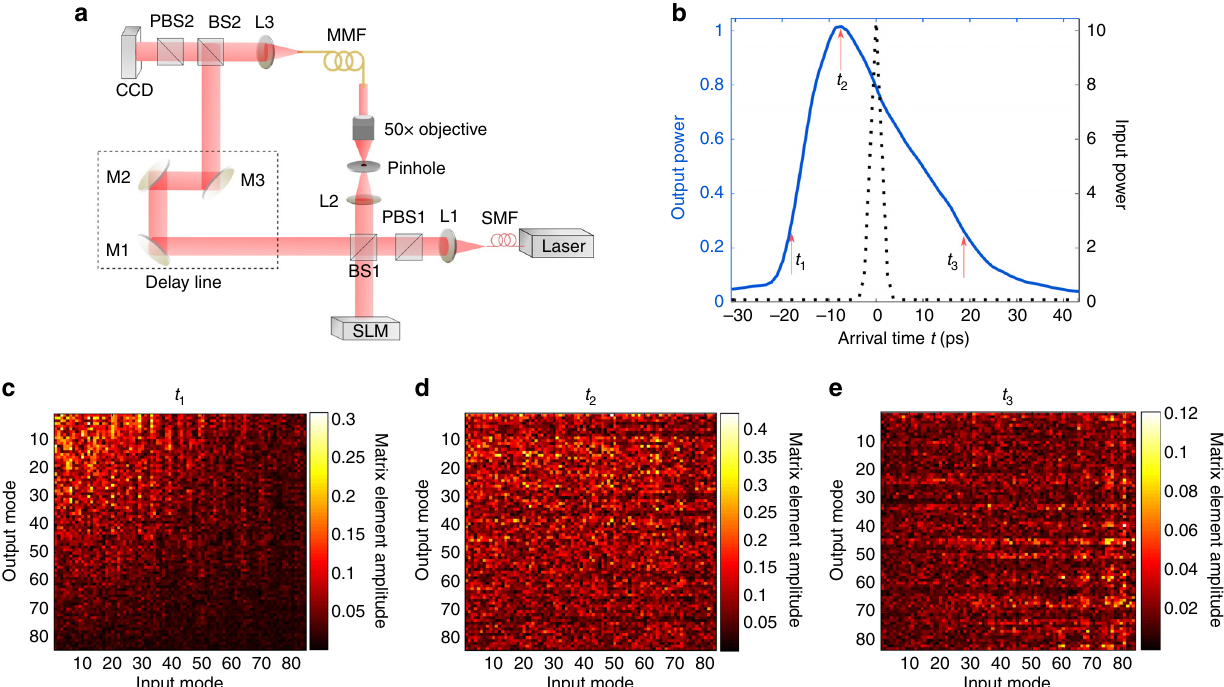
Fig. 1 Time-dependent transmission matrix of an MMF. a Schematics of experimental setup for both transmission matrix measurement and wavefront shaping. A laser beam with tunable frequency is collimated, and its horizontal polarization is selected and split into two arms, with one being the reference and the other propagating through the MMF after re fl ecting off a spatial light modulator (SLM). The SLM is demagni fi ed and imaged onto the MMF facet. Light transmitted through the MMF is recombined with the reference plane wave, and its horizontal polarization is imaged onto a CCD camera. The path lengths of the two arms are matched by tuning the delay line formed by mirrors M1 – M3. L, lens; BS, beam splitter; PBS, polarizing beam splitter. b Temporal shapes of the input pulse (black dotted line, right axis) and the mean eigenvalue of u y ð t Þ u ð t Þ (blue solid line, left axis) representing the transmitted intensities of random spatial inputs. The two curves are normalized to have the same area. c – e Magnitudes of the measured time-dependent transmission matrices at three arrival times (marked by red arrows in b ), showing strong mode mixing in the fi ber. The transmission matrices are measured in k space at input and real space r at output, and subsequently converted to the fi ber mode basis